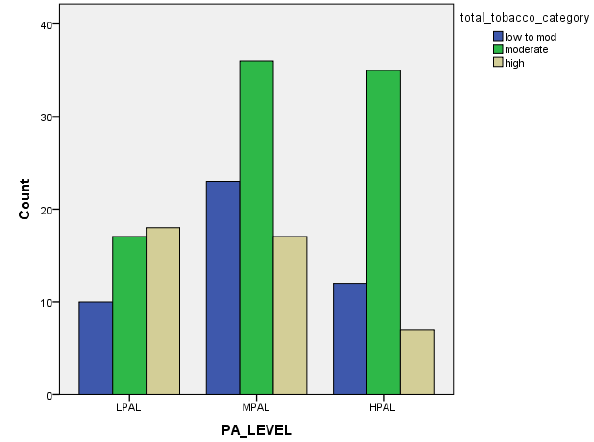
Figure 6. Frequency of tobacco and alcohol consumption depending on year of study (female).